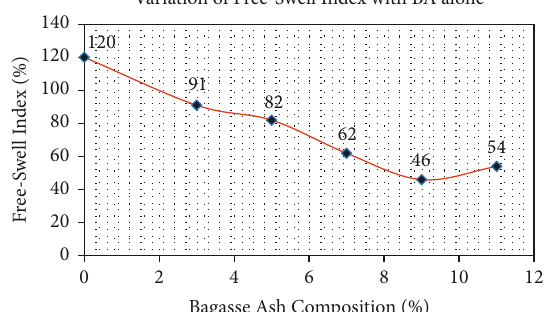
Figure 7: Effect of BA on the free-swell index.